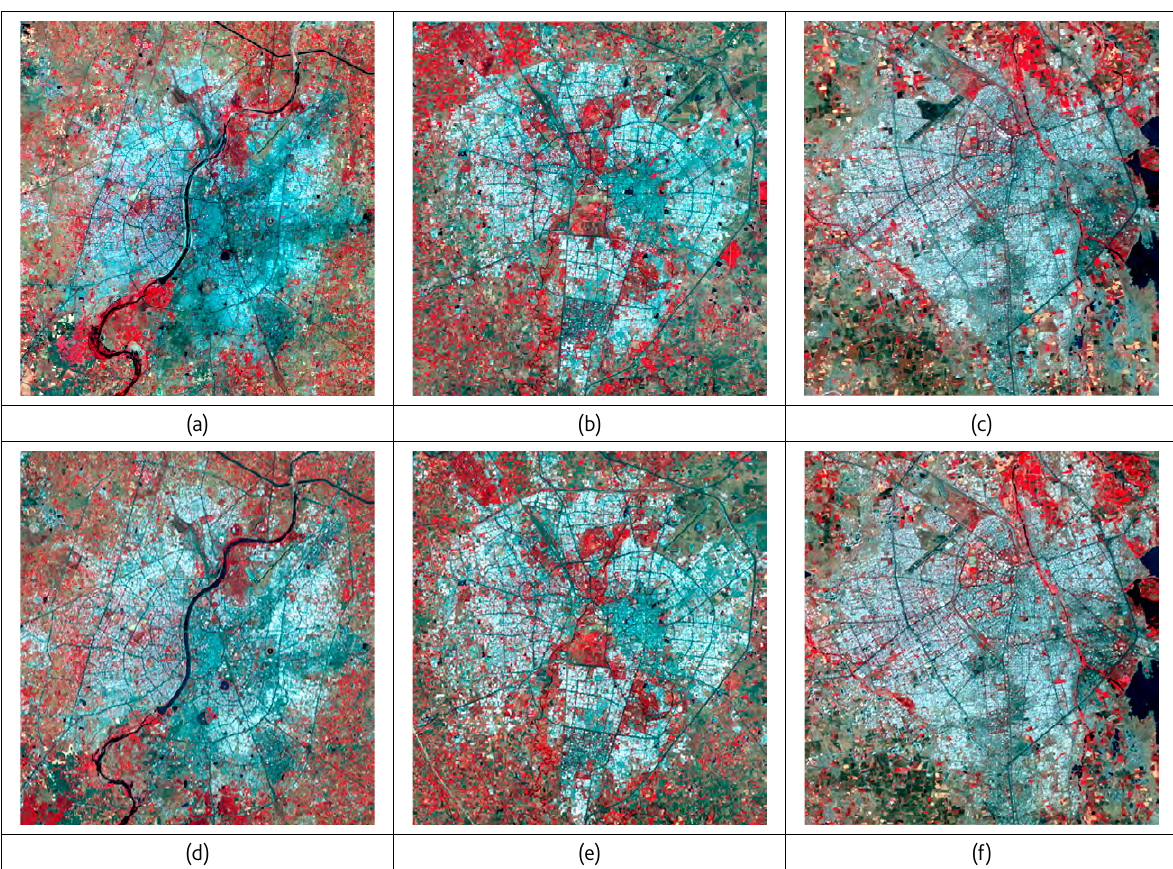
Figure 1. Images of the study area (a) Ahmedabad of year 2011, (b) Vadodara of year 2013, (c) Rajkot of year 2014,